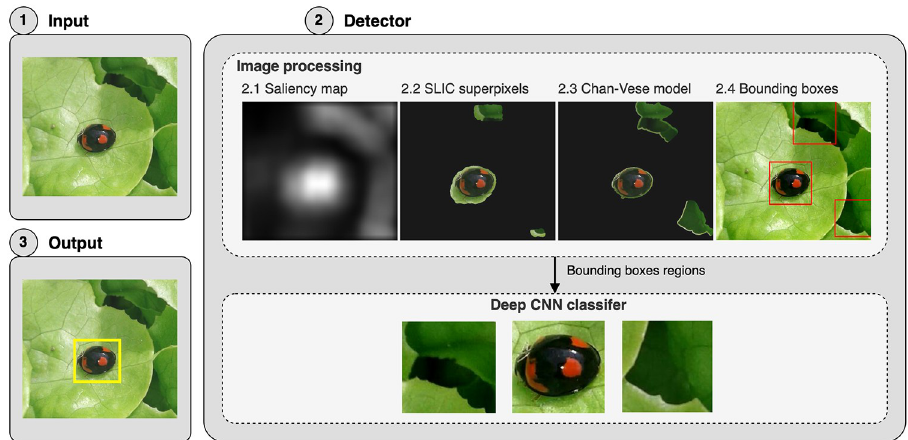
Fig 2. Workflow of the proposed